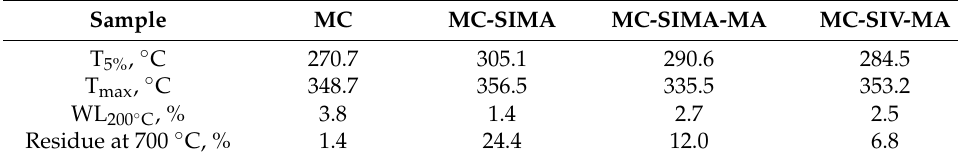
Figure 4. Thermogravimetric ( a ) and derivative ( b ) curves of MC and modified celluloses. Table 1. Thermogravimetric data for the modified celluloses .